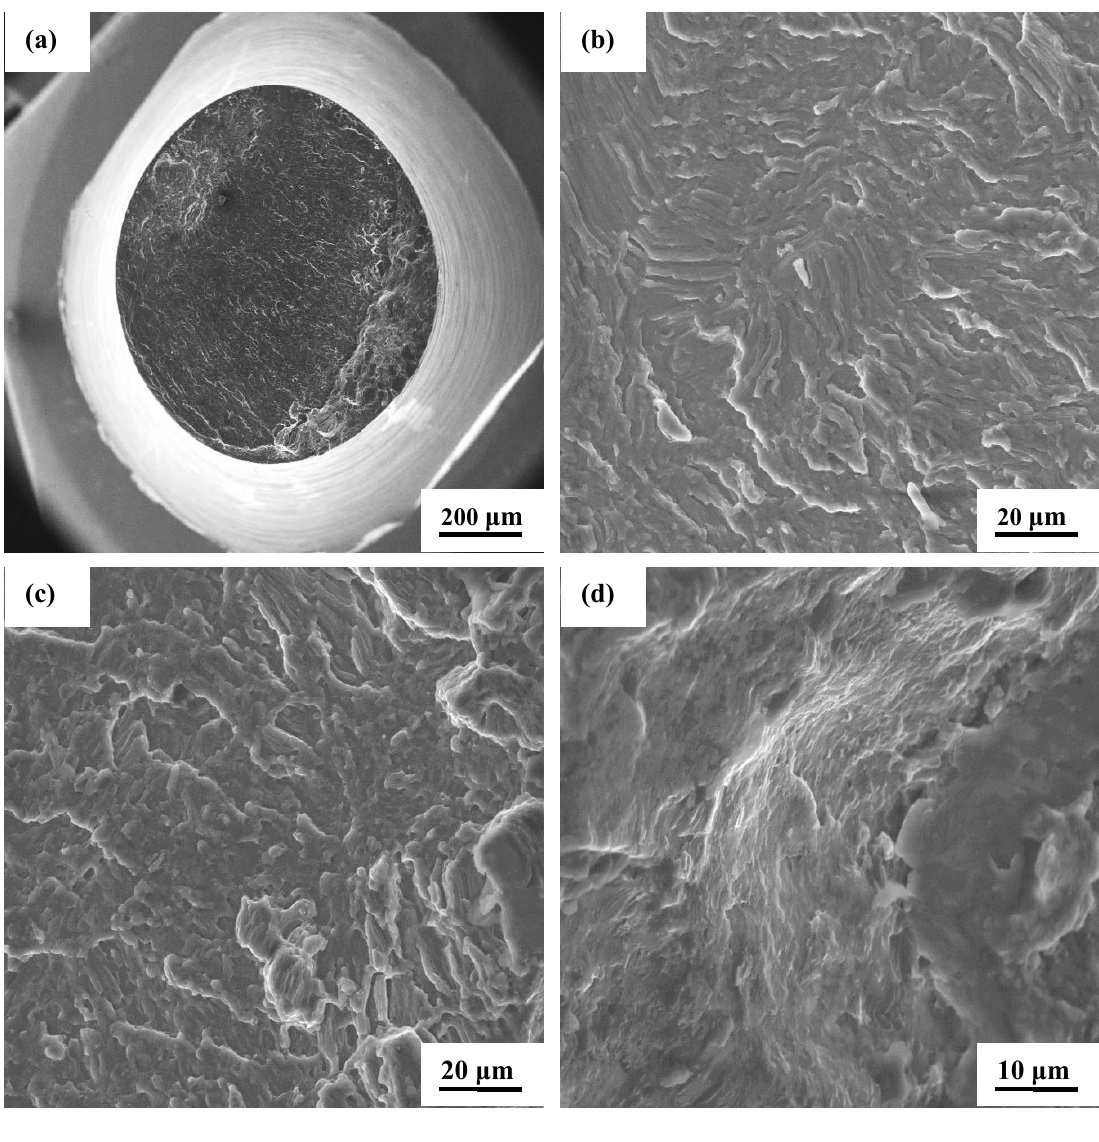
Figure 13. Scanning electron micrographs of the high cycle fatigue fracture surface of AZ31 + Al O containing 1.5 wt pct nickel deformed at maximum cyclic stress of 2 3 84.03 MPa at load ratio of − 1, fatigue life of 655,970 cycles, showing the following: ( a ) Overall morphology of the fracture surface predominantly normal to the far field stress axis; ( b ) High magnification observation of (a) in the region of early microscopic crack growth showing pockets of randomly dispersed striations; ( c ) The key features on the fracture surface with shallow striations in the region immediately prior to overload and ( d ) The transition region between the smooth fatigue region and overload laden with fine microscopic voids and shallow